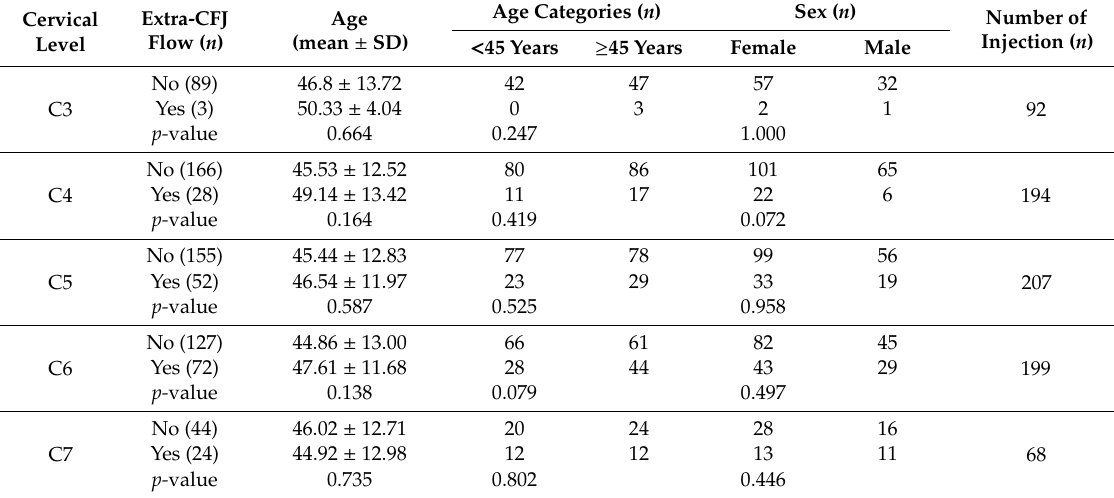
Table 2. Summary statistics of study population.